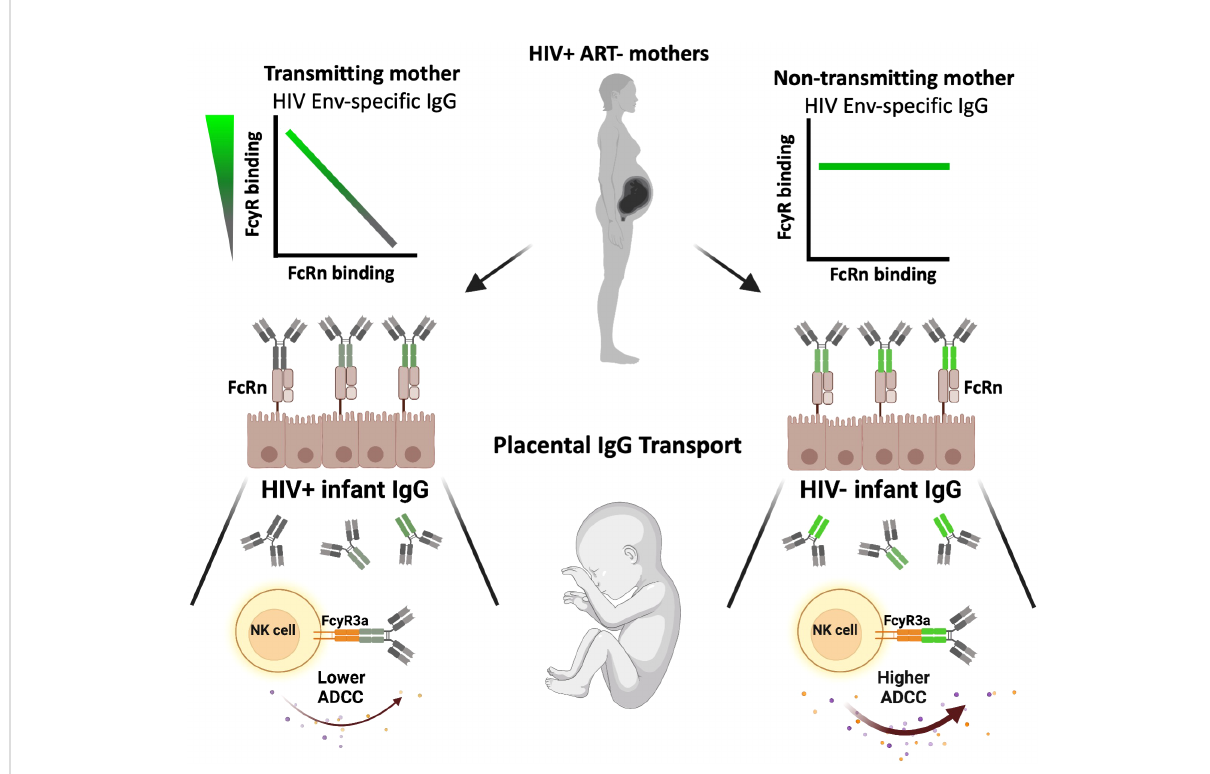
FIGURE 6 Graphical summary of the impact of maternal antibody pro fi le on transplacental IgG transport, infant immunity and vertical transmission. On the left, transmitting mothers demonstrated a signi fi cant inverse correlation between FcRn-reactive and Fc g R-reactive Env-speci fi c plasma IgG (top), resulting in FcRn-mediated transplacental transport of IgG with lower Fc g R-reactivity (middle), and therefore lower infant plasma IgG ADCC activity (bottom). Conversely, on the right, non-transmitting mothers demonstrated no signi fi cant relationship between FcRn-reactive and Fc g R- reactive Env-speci fi c plasma IgG (top), resulting in FcRn-mediated transplacental transport of IgG with unbiased Fc g R-reactivity (middle), and therefore infant with higher plasma IgG ADCC activity as compared to the HIV+ infant counterparts